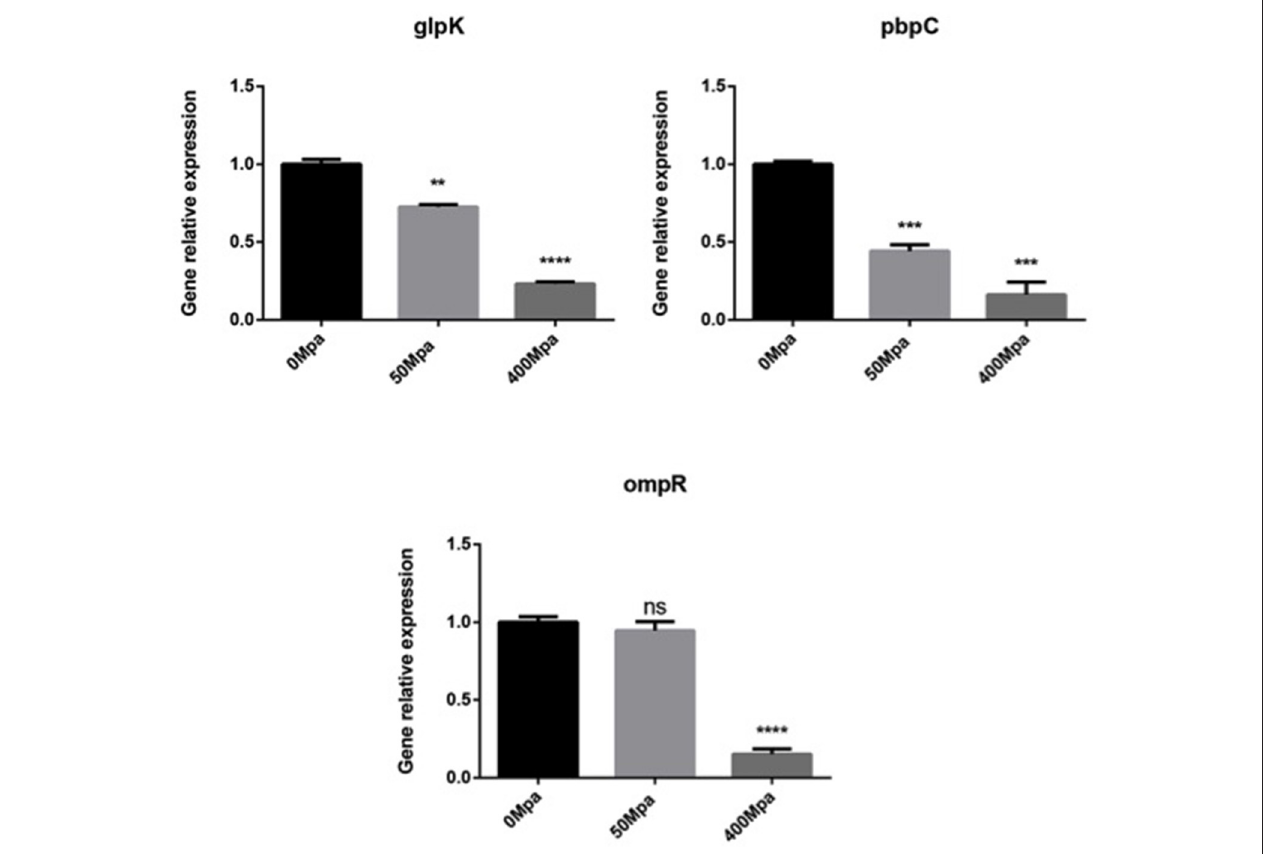
FIGURE 3 | Expression of selected cell membrane genes in E. sakazakii treated with HHP. Asterisks indicate difference between control and different HHPs at * P < 0.05, ** P < 0.01, *** P < 0.001, and **** P < 0.0001.